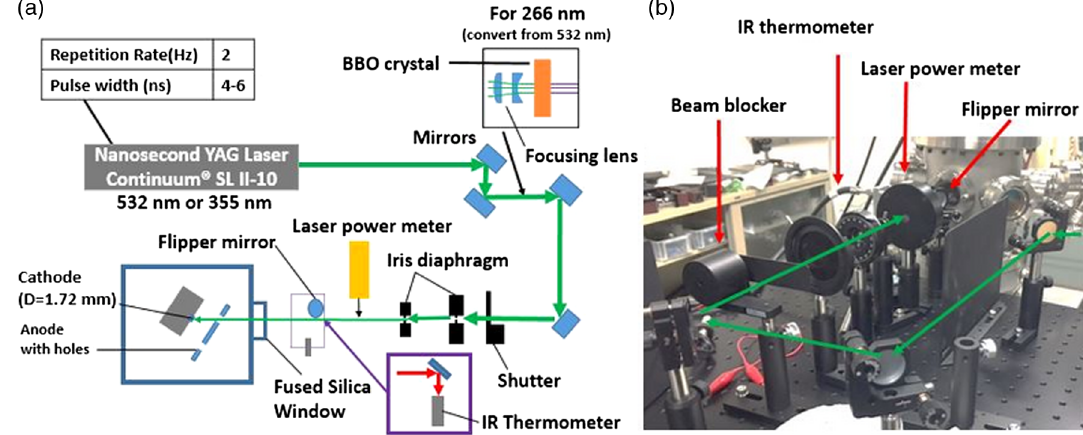
FIG. 2. Experimental setup. (a) Schematic view. (b)